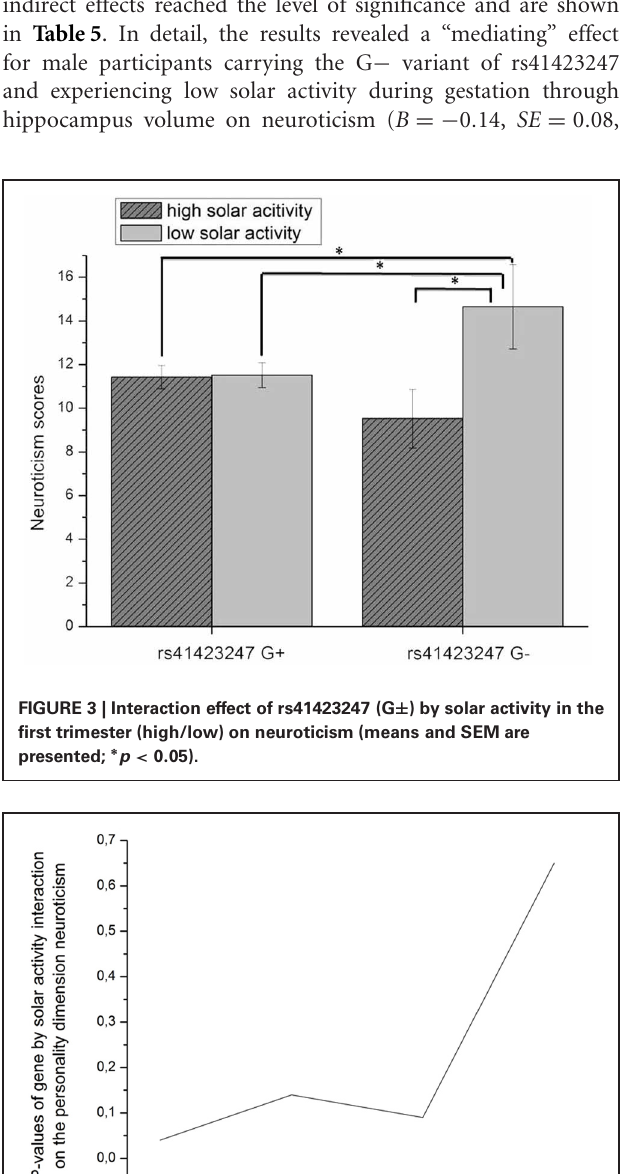
Table 4 | Decline of the interaction effect gene by solar activity from the first trimester to birth on neuroticism ( η 2 are partial η 2 ).